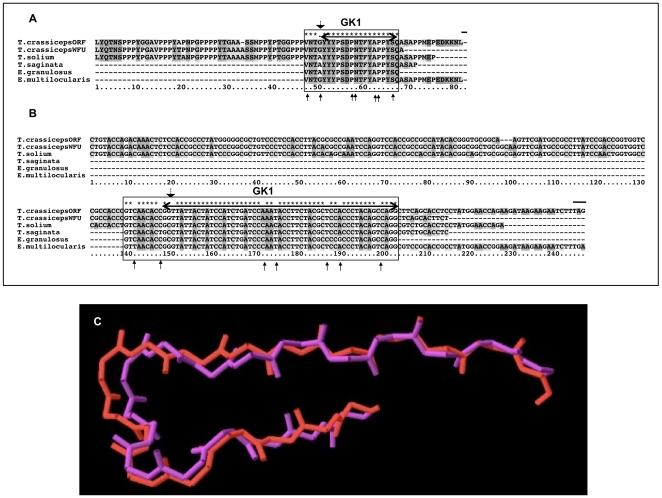
Multiple sequence alignment GK1 peptides.The DNA and amino acid sequences of GK1 in several species of the Taeniidae family were aligned. GK1 alignments of amino acids (A) and cDNA (B) are shown in the upper part of the figure; the region encoding the actual peptides is marked with a double-headed arrow on the top of the alignment. On every alignment, boxes corresponding to the regions subjected to dN/dS-ratio analysis are marked accordingly. Models of the 3D structure of the GK1 peptide are shown in panel C. The model in red corresponds to T. solium, T. saginata and E. granulosus' GK1 and in purple to T. crassiceps ORF and WFU and E. multilocularis. A very good fitting between the two structures is shown as expected from the strong similarity of the amino acid sequence.